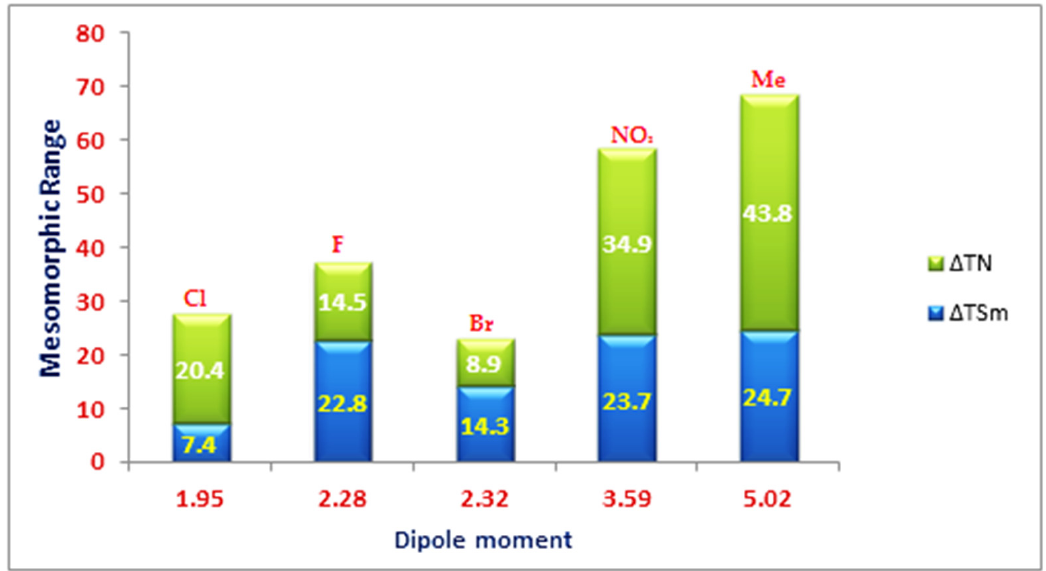
Figure 6. Dependence of the mesomorphic range with the calculated dipole moment.